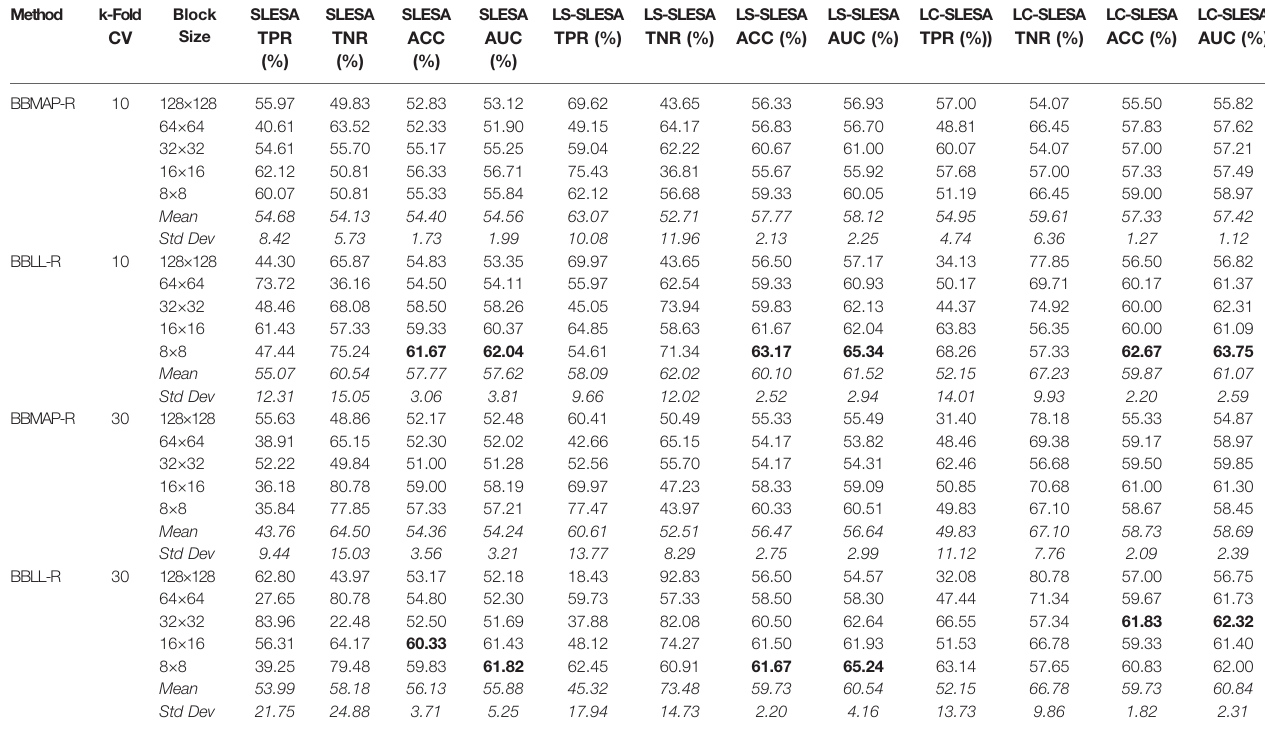
The top performances of 10- and 30-fold cross-validation are shown in